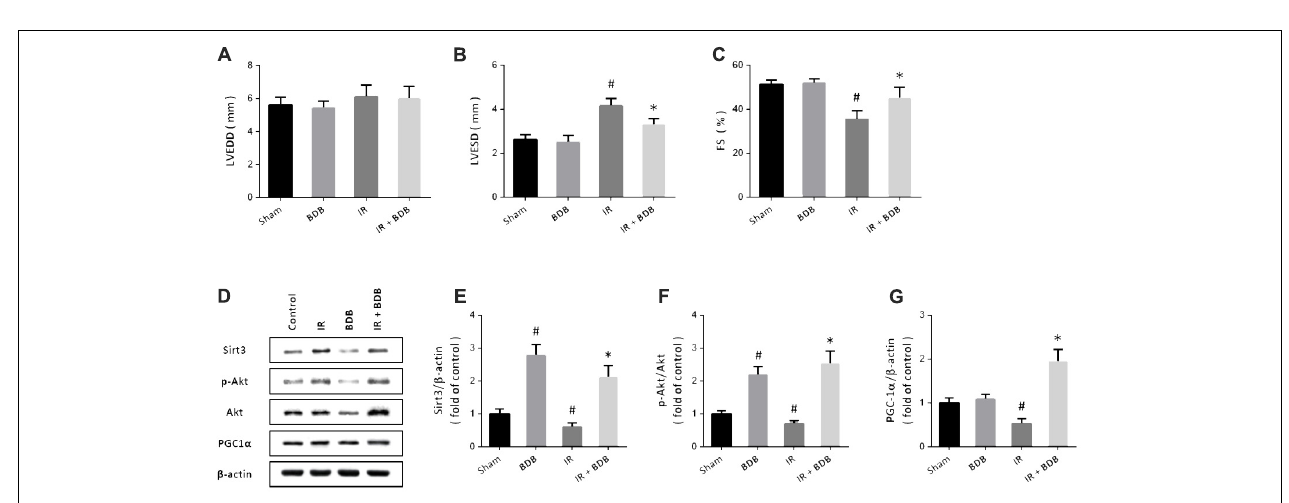
FIGURE 6 | Cardioprotective effects of BDB in vivo . (A–C) Echocardiographic parameters show that BDB had no effect on LVEDD (A) , but decreased LVESD (B) and increased FS (C) after myocardial IR in rats. (D–G) Western blot (D) and quantification show that BDB increased the expression of Sirt3 (E) and PGC1 α (F) and Akt phosphorylation (G) after myocardial IR in rats. Data are shown as mean ± SEM ( n = 6). # p < 0.05 vs. Sham. ∗ p < 0.05 vs.